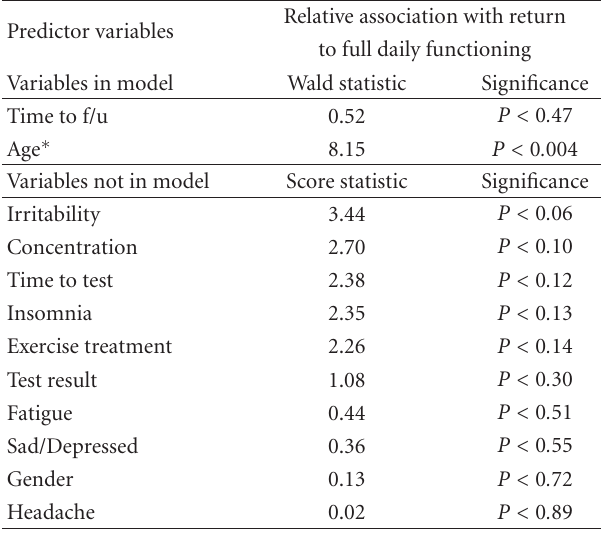
Table 4: Relative associations of predictor variables with return to full daily functioning a